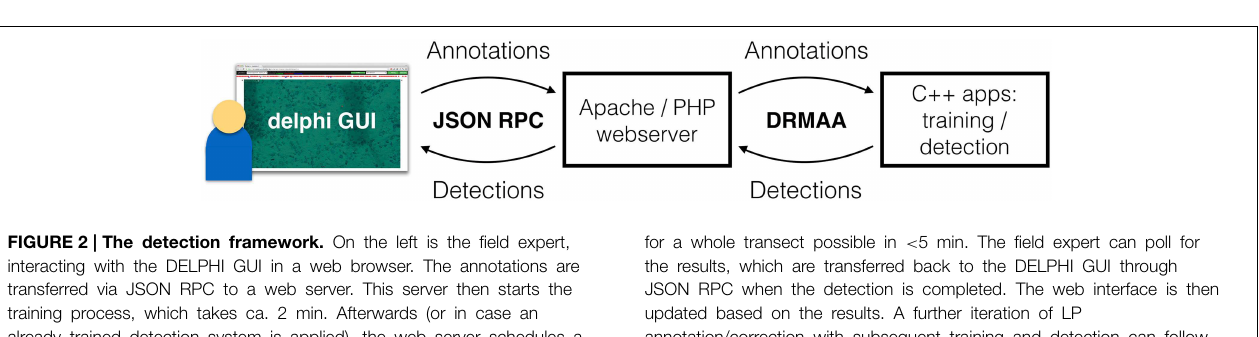
whole width of the interface. Red rectangles stand for images where laser points were automatically detected, blue rectangles stand for images that have been annotated. The main part of the browser window is occupied by one transect image, in this case with three correctly detected LPs (highlighted for the figure with light blue circles). To the left/right of the image are arrows that allow to step to the previous/next image of the transect. In the top left part of the image are the buttons to zoom in and out of the image as well as move the image itself to the top/ bottom and left/right respectively to set the focus on the region of the image where laser points occur.